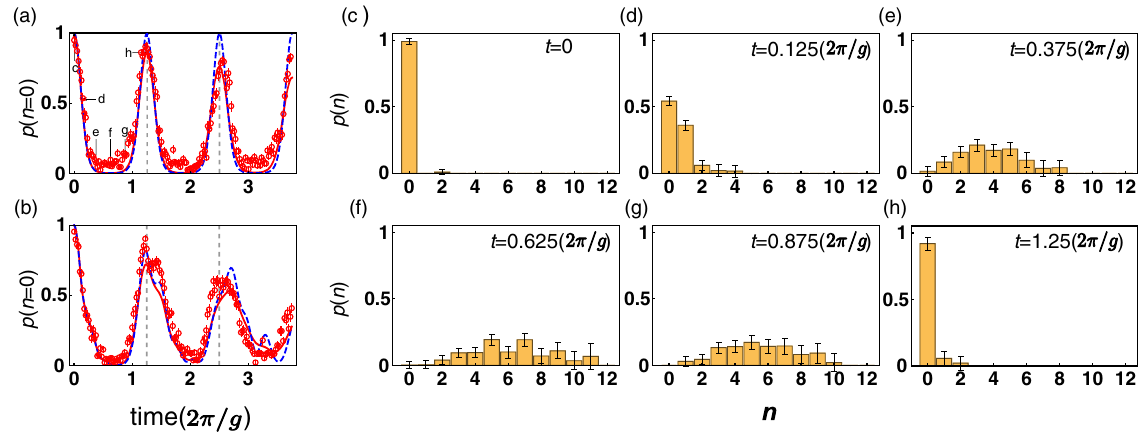
FIG. 2. Phonon-number wave packets bouncing back and forth in the DSC regime. In panels (a) and (b) we plot the population of state j n ¼ 0 i , after tracing out the spin, as the system evolves under the QRM in the DSC regime. In particular, panel (a) shows the degenerate 1 . 25 . Dashed and case, ω 0 ¼ 0 , and (b) the nondegenerate case, with ω 0 ¼ 0 . 8 g . For both cases, the coupling ratio is fixed to g= ω m ¼ solid lines represent theoretical calculations with and without decoherence of the motional mode, respectively. The vertical dashed lines indicate the motional revival times k ð 2 π = ω , where k ¼ 1 ; 2 ; … . The data points with error bars correspond to the experimental results. m Þ We obtain the zero-phonon population following the method in Ref. [14] after tracing out the spin. Panels (c) – (h) show the phonon- 100 μ s of the QRM Hamiltonian for the degenerate number distribution sampled at several instants during one period T ¼ ð 2 π = ω m Þ ¼ case. The phonon distribution is obtained by fitting the standard blue-sideband signals to Eq. (C1) after tracing out the spin (see Appendix C). At the first revival time, the phonon state is back to the initial state as predicated by the QRM. The imperfections can be attributed to decoherence of the motional degrees of freedom.